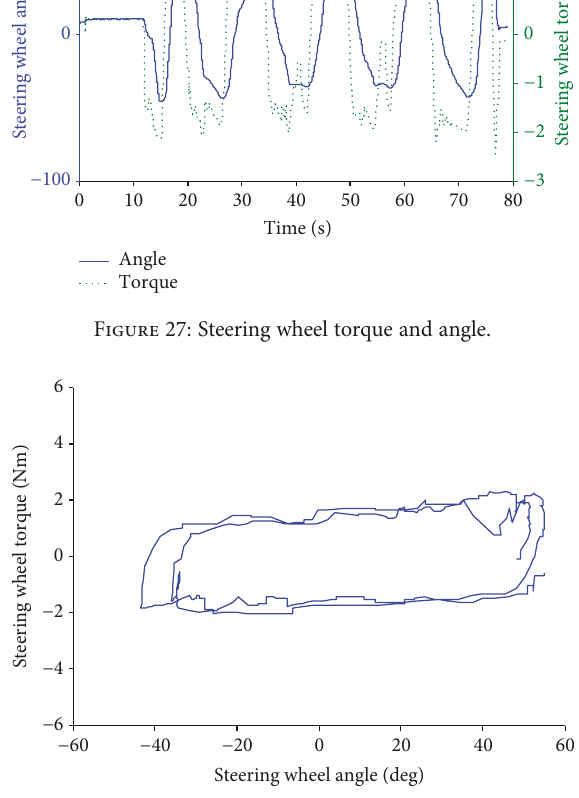
Figure 28: The relationship between steering wheel torque and